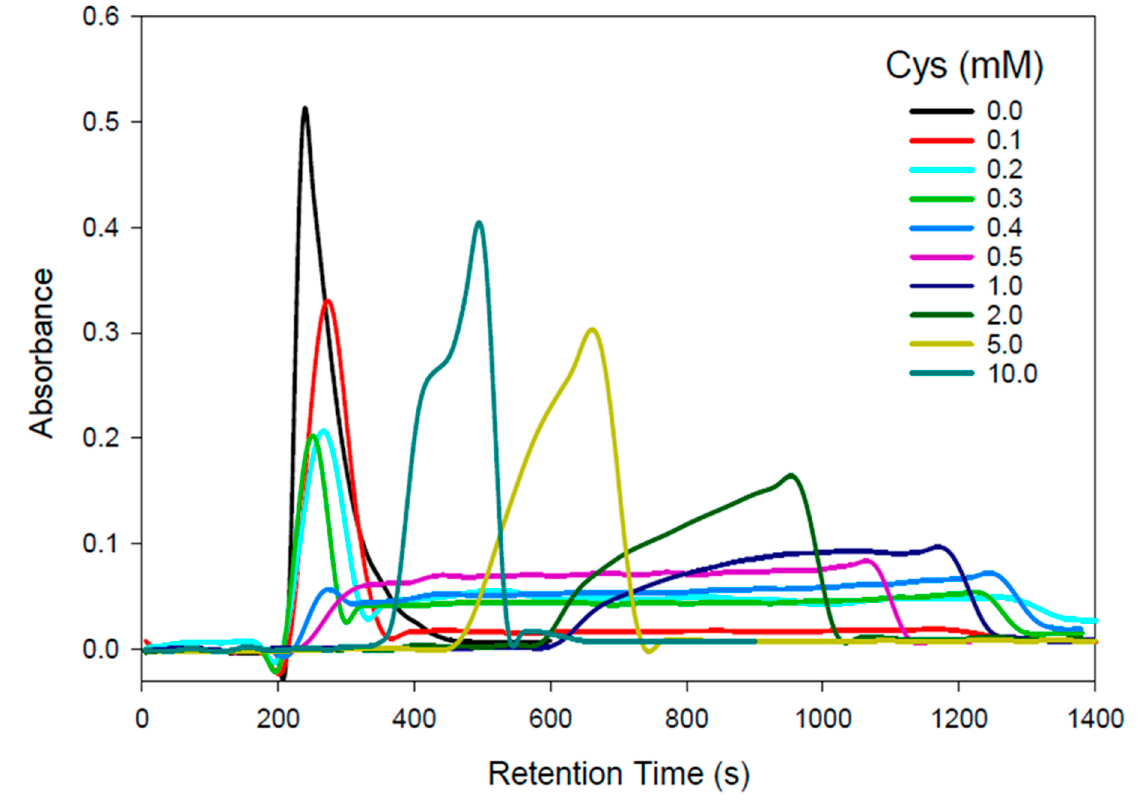
Figure 1. Representative Cd-specific chromatograms obtained by HPLC-FAAS for the analysis of Cd 2+ (50 µ g) on a PRP-X100 anion-exchange column (250 mm × 4.1 mm ID; 10 µ m particle size) with a 100 mM NaCl mobile phase that contained 5 mM Tris-buffer (pH 7.4). Flow rate: 1.0 mL/min; injection volume: 50 µ L (50 µ g Cd 2 + ); detector: flame atomic absorption spectrometer at 228.8